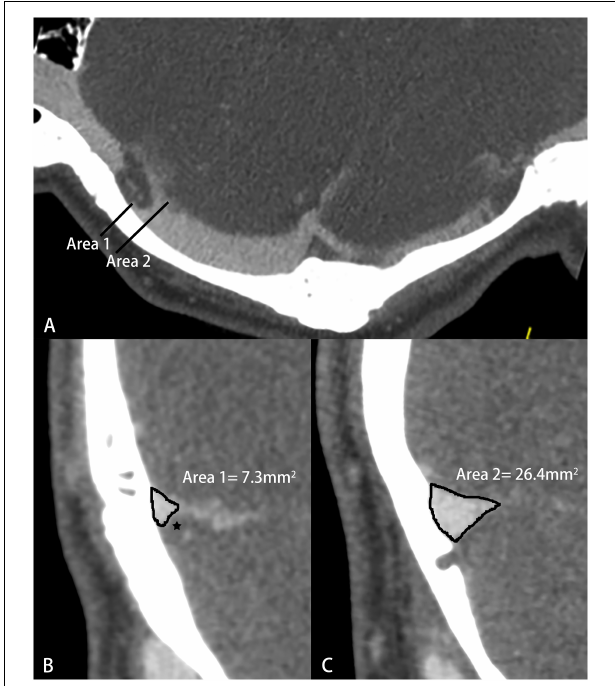
FIGURE 2 | Schematic diagram of transverse sinus stenosis (TSS) measured by computed tomography venography (CTV). (A) Curve planar reformation image; (B) The most severe cross section of TSS, (cid:70) -arachnoid granulation; (C) Normal transverse sinus cross-sectional